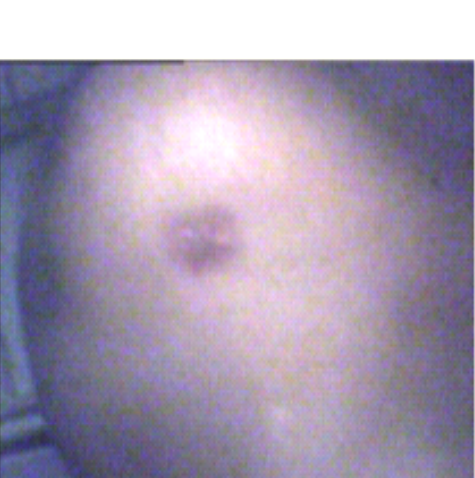
Figure (8): inta operative picture after the removal of the infected cyst. This patient has been given 600 mg Clindamycin 1 hr.